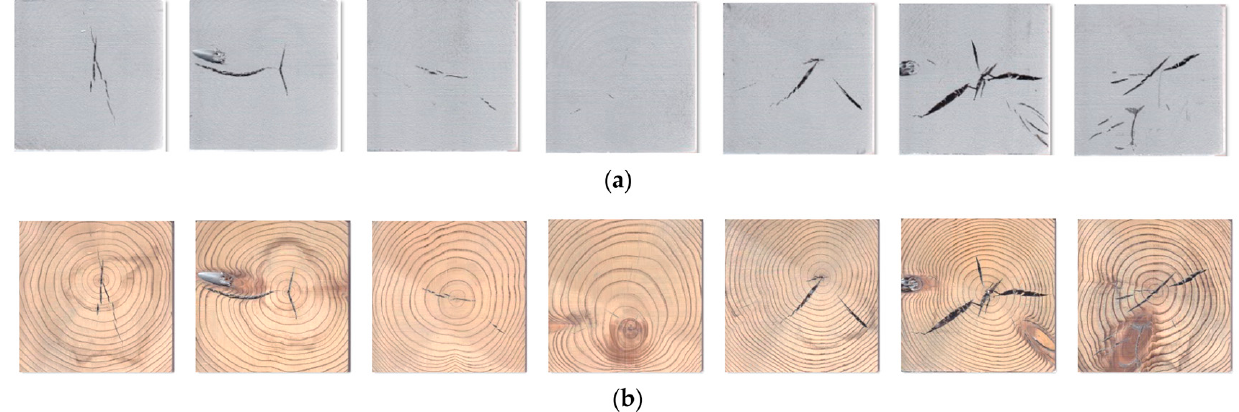
Figure 3. Cross-sectional pictures. ( a ) Silver-painted picture employed in our previous study [8,9]; ( b ) Corresponding unpainted pictures.